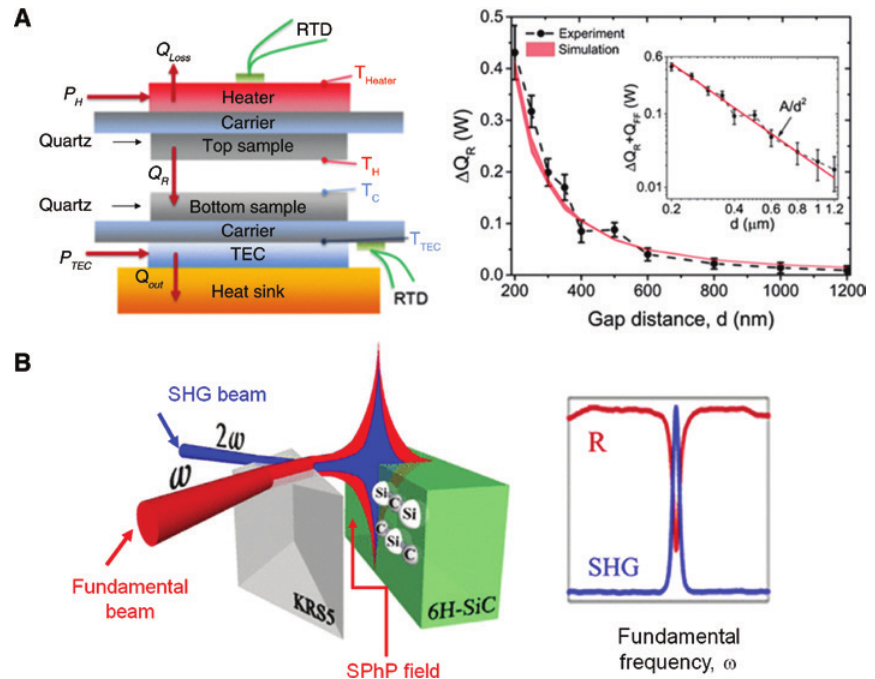
Figure 18: Examples of SPhP-enabled phenomena. (A) SPhP-enabled enhanced near-field heat transfer: (Left) heat transfers from a hot to a cold quartz plate, separated by a distance, d ; (Right) Observation of a ∝ 1/ d 2 scaling law, a signature of near-field heat transfer facilitated by the SPhP. (Reprinted with modification with permission from [194] (see link at https://journals.aps.org/prl/abstract/10.1103/PhysRevLett.120.175901). Copyright 2018 American Physical Society.) (B) SPhP-enabled enhanced second harmonic generation (SHG): (Left) The fundamental beam couples via an ATR prism to a SPhP mode supported at the air-SiC interface. (Right) The coupling to SPhP manifests itself as a dip in the reflectivity spectrum (red line), giving rise to a SHG signal that out-couples on the other side of the prism (blue line). (Reprinted (adapted) with permission from